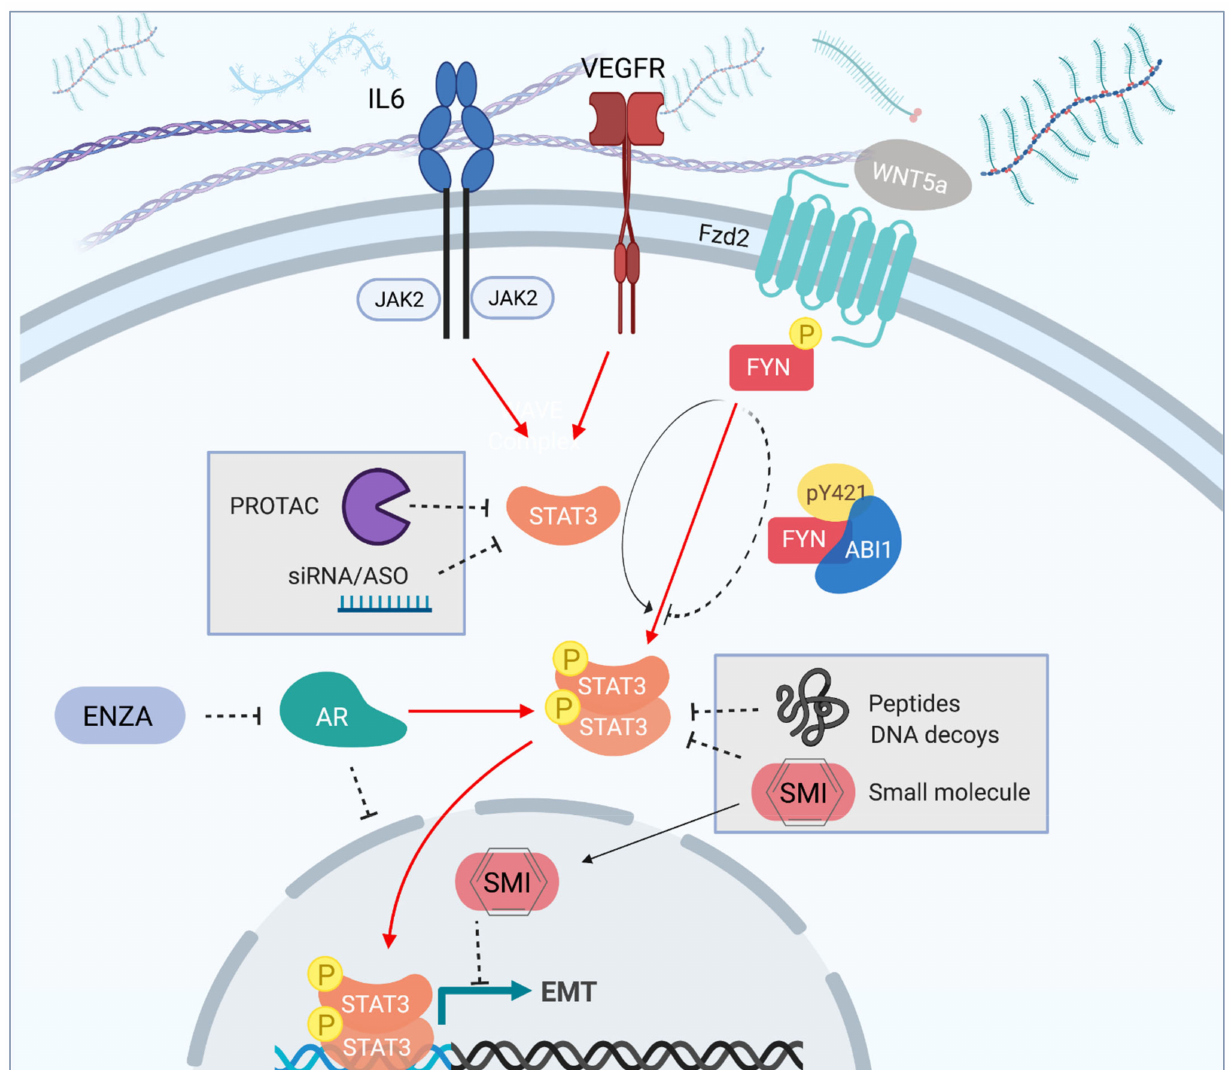
Figure 2. STAT3 as potential target pathway in nmCRPC. Major types and mechanisms of current STAT3 inhibitors: siRNA/ASO, polypeptides, DNA decoys, small molecule and/or PROTAC inhibitors. The goal of inhibitors is to decrease levels of STAT3 mRNA or protein (siRNA/ASO or PROTAC), to inhibit STAT3 nuclear translocation (DNA decoys), or the transcriptional activity by interfering with DNA binding (peptides or small molecule inhibitors). Major pathways regulating STAT3 signaling in prostate epithelial cells are